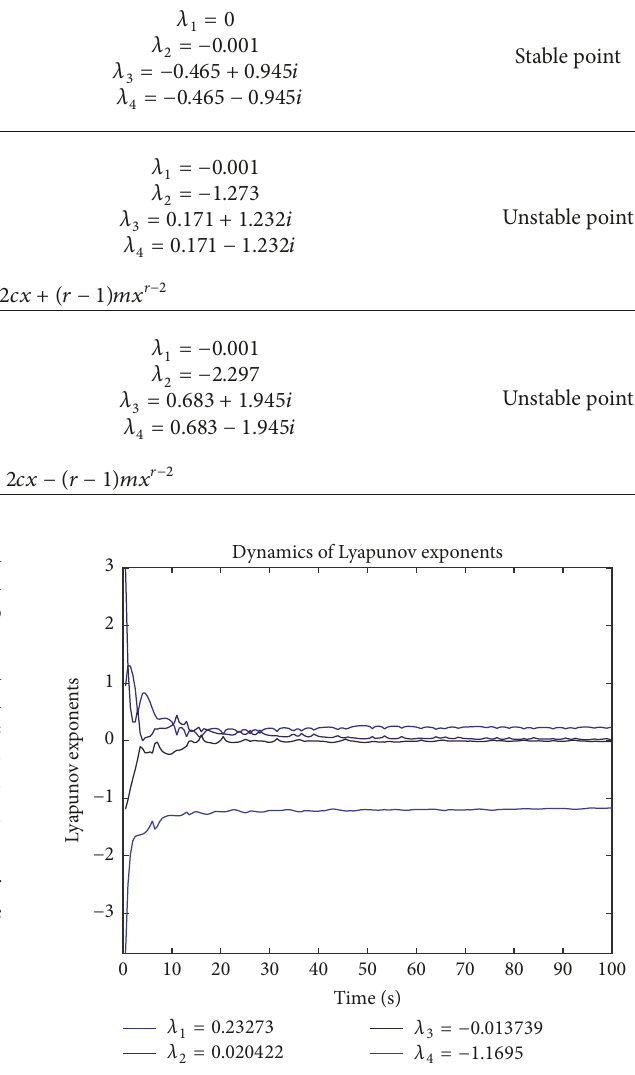
Figure 3: The Lyapunov exponent spectrum of the hyperchaotic system